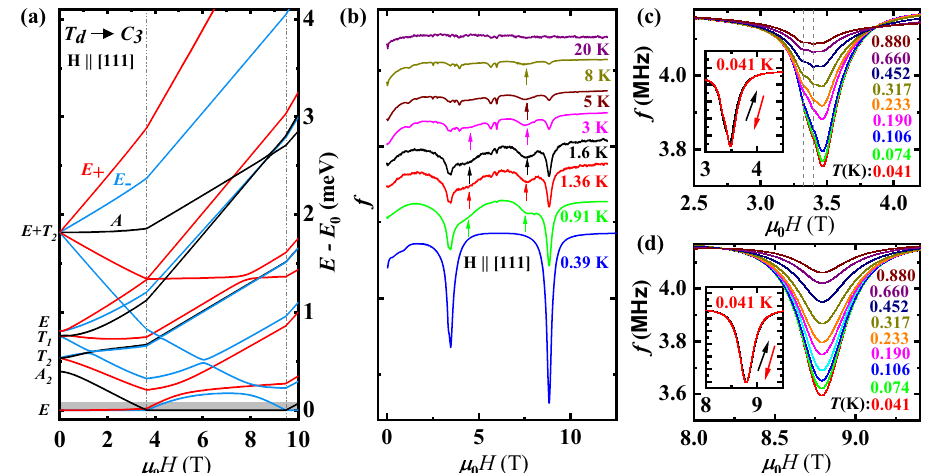
Fig. 2 Energy levels and fi eld-induced transitions. a Field-dependent energy levels calculated by the single-tetrahedron model. Irreducible representations of the zero fi eld ( T d ) and fi nite fi eld ( C 3 ) symmetry groups are indicated. Critical fi elds where there is a ground state level crossing ( μ 0 H c1 = 3.65 T and μ 0 H c2 = 9.48 T) indicated by vertical dash lines are close to the experimental values. The low energy regime (e.g., as would be thermally populated at T ≲ 1 K) is indicated by a gray shaded box. b Tunnel diode oscillator (TDO) frequency ( f ) as a function of magnetic fi eld H ∥ [111] up to 20 K. Traces are shifted vertically for clarity. Small dips in frequency in addition to two level crossings are marked by arrows. The nature of these small anomalies calls for further investigation. The sharp features at higher temperatures, e.g., near ~6 T, are associated with background signal from our experimental apparatus. c , d f vs H ∥ [111] as a function of magnetic fi eld H ∥ [111] up to 0.880 K, near the ground state level crossings at c 3.5 T, and at d 8.8 T. Additional features observed ~3.5 T are marked by gray dash lines. Insets in c and d show f vs H ∥ [111] for the upsweep (black) and downsweep (red) at T = 0.041 K, where no hysteresis is